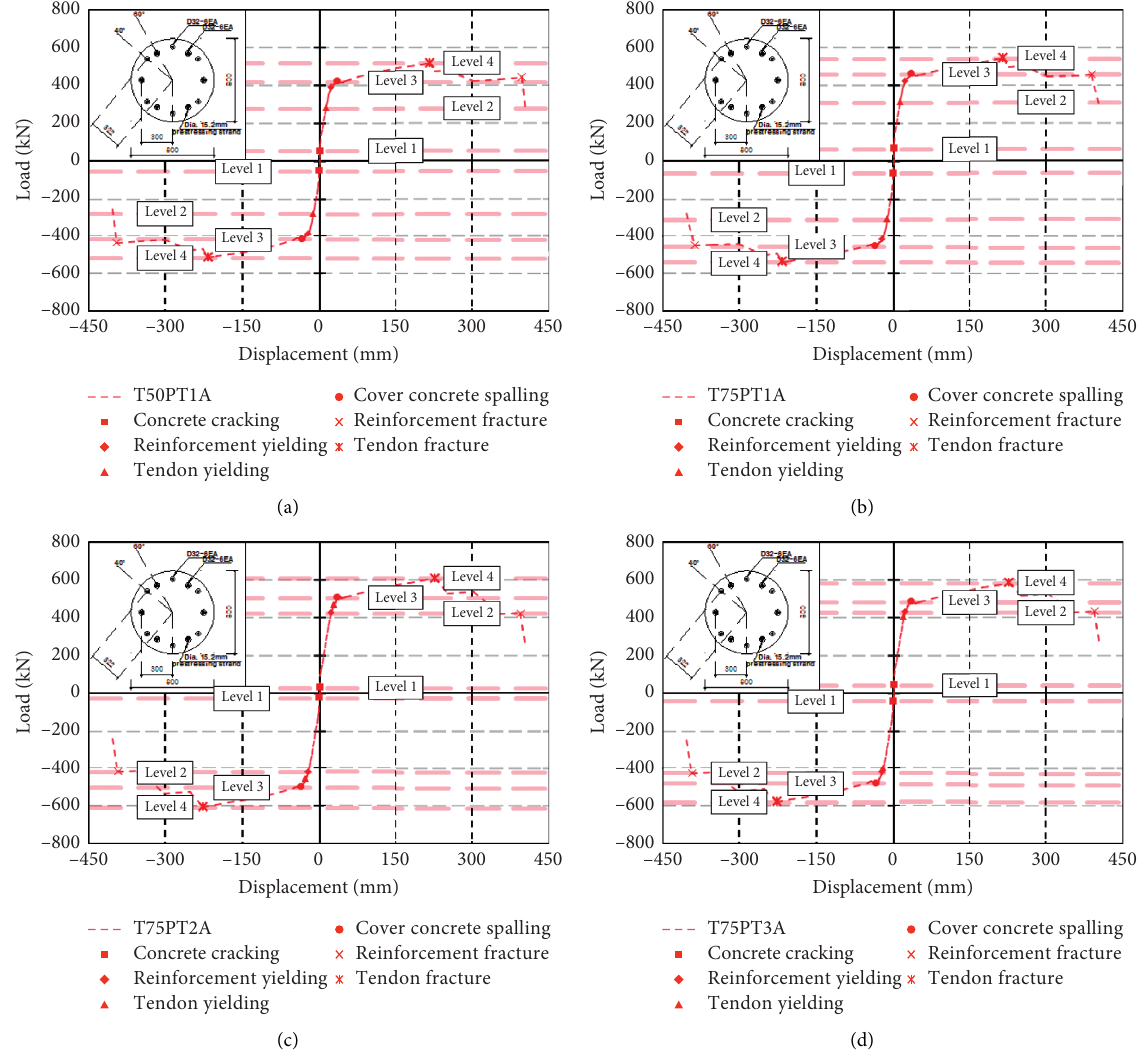
Figure 12: Load-displacement envelope curve by M-Phi analysis with performance level. (a) T50PT1A. (b) T75PT1A. (c) T75PT2A. (d)